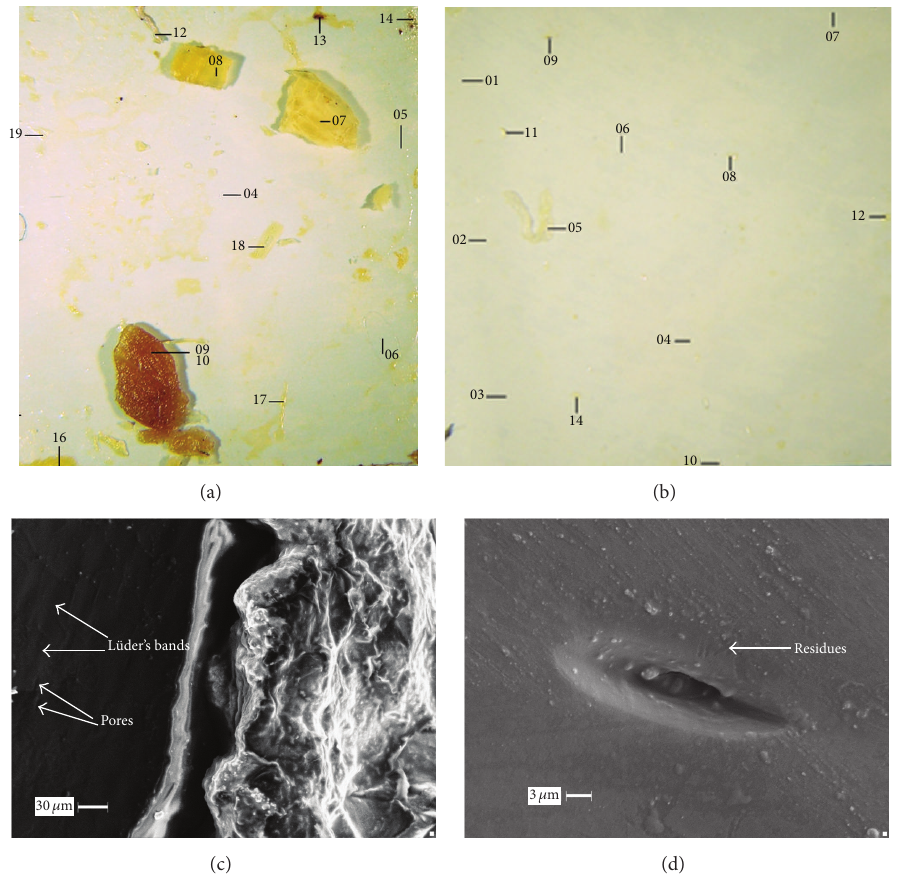
Figure 2: (a) The highest localized salmon adhesion occurred in samples stored for 16 months. It is possible to observe several zones of adhesion displayed in grey color of varied intensities. The white surfaces showed no evidence of changes on the PET coating ( × 10). The lines and numbers correspond to points of spectroscopy analyses [17]; (b) PET polymer surface with small residues (grey) of salmon muscle that remained attached after the application of urea solution ( × 10) [17]; (c) muscle morphology with peptide multilayers on PET surface with manufacturing defects (SEM); (d) muscle residues strongly adhered to the pore edge of the polymer coating posturea treatment